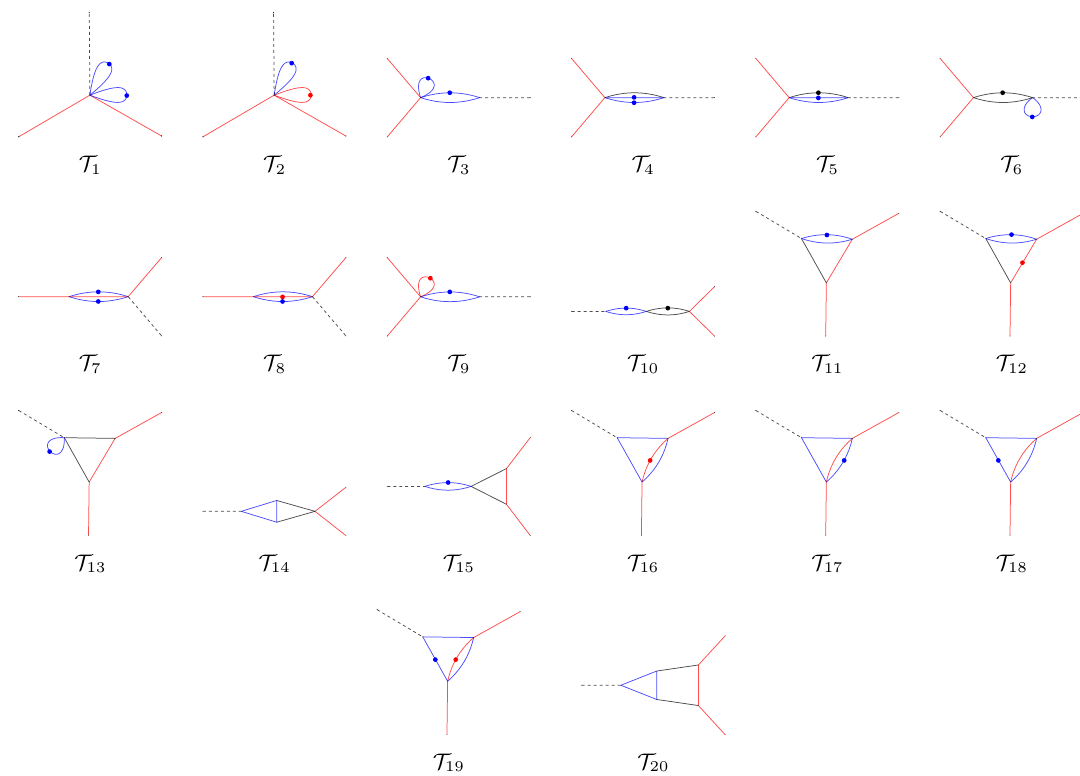
Figure 5. Master integrals required for the evaluation of the scalar and pseudo-scalar form factors, corresponding to the two-loop diagrams in figure 1. In each diagram, we indicate the off-shell external mediator (dashed lines), fermions with mass m massless photons (black lines) and squared denominators